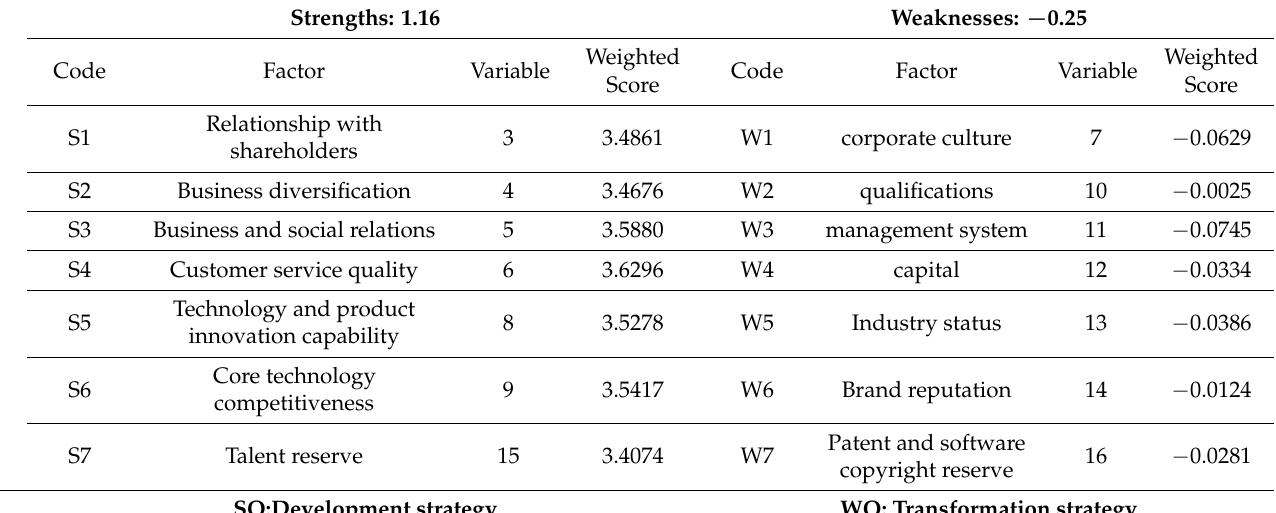
Table 3. The Rotated Component